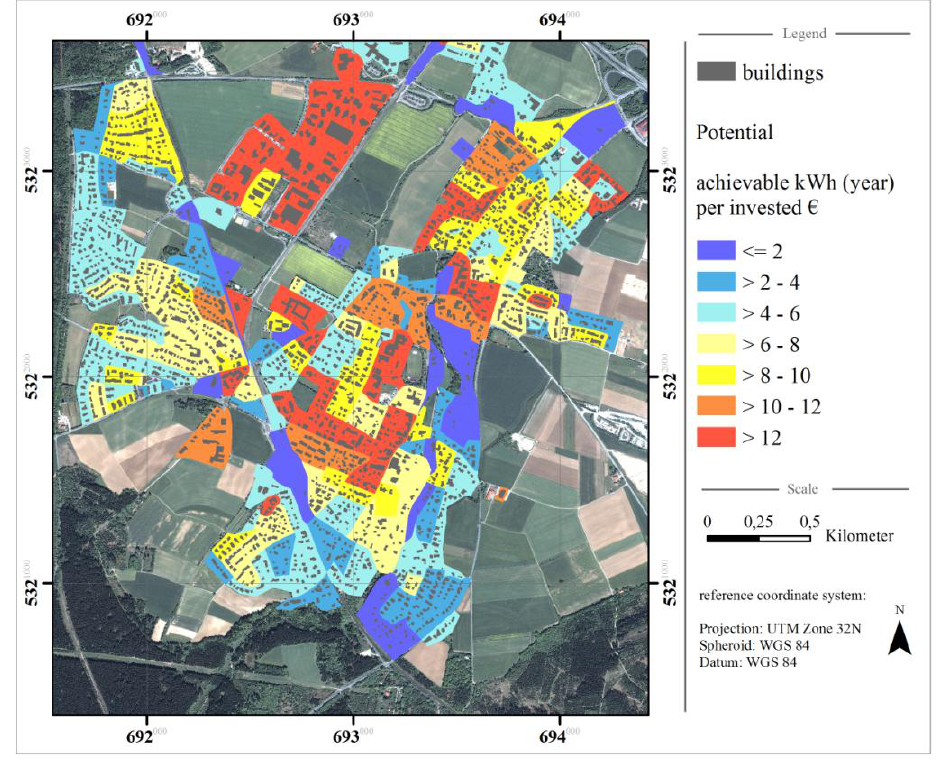
Figure 4. Assessed potentials for district heating for the test site (Oberhaching,